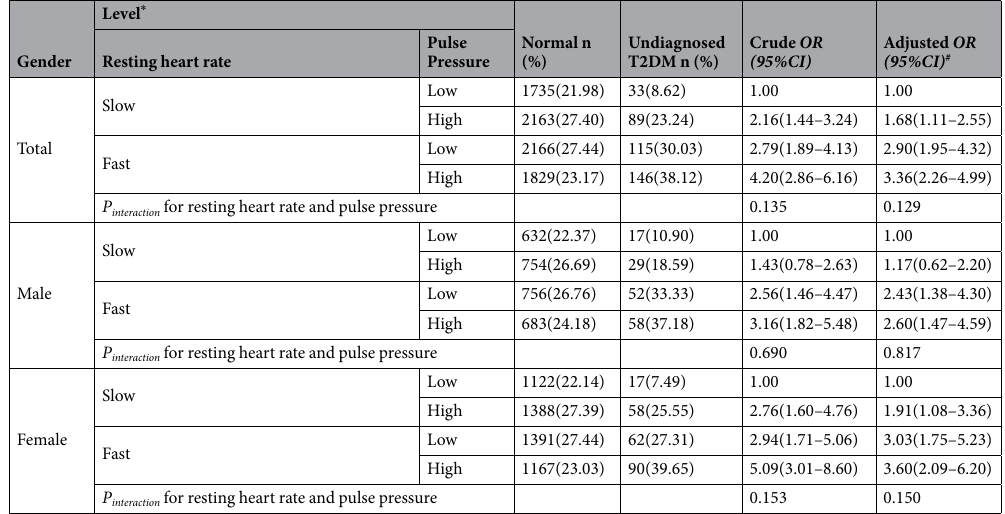
Table 3. Cumulative effect of slow/fast resting heart rate and low/high pulse pressure for undiagnosed T2DM (n = 8276). * Slow and low are defined as ‘Q1 + Q2’, and fast and high are defined as ‘Q3 + Q4’. #Adjusted for